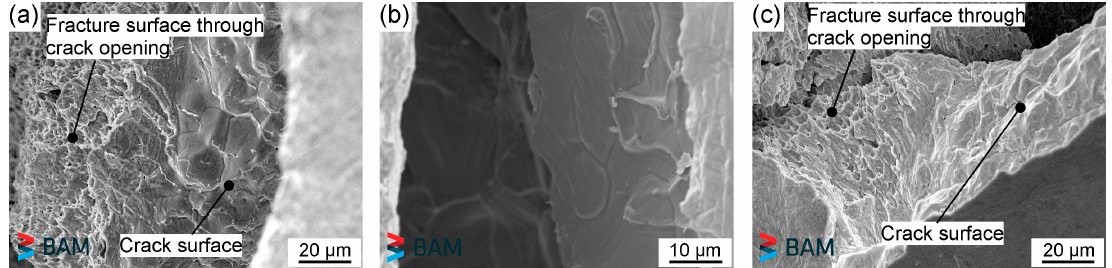
Figure 13. Topography of opened micro-cracks of solid wire at α = 30° for ( a ) H D = 5.7 mL/100 g and ( b ) H D = 1.2 mL/100 g and ( c ) of metal cored wire at α = 60° with DHT.